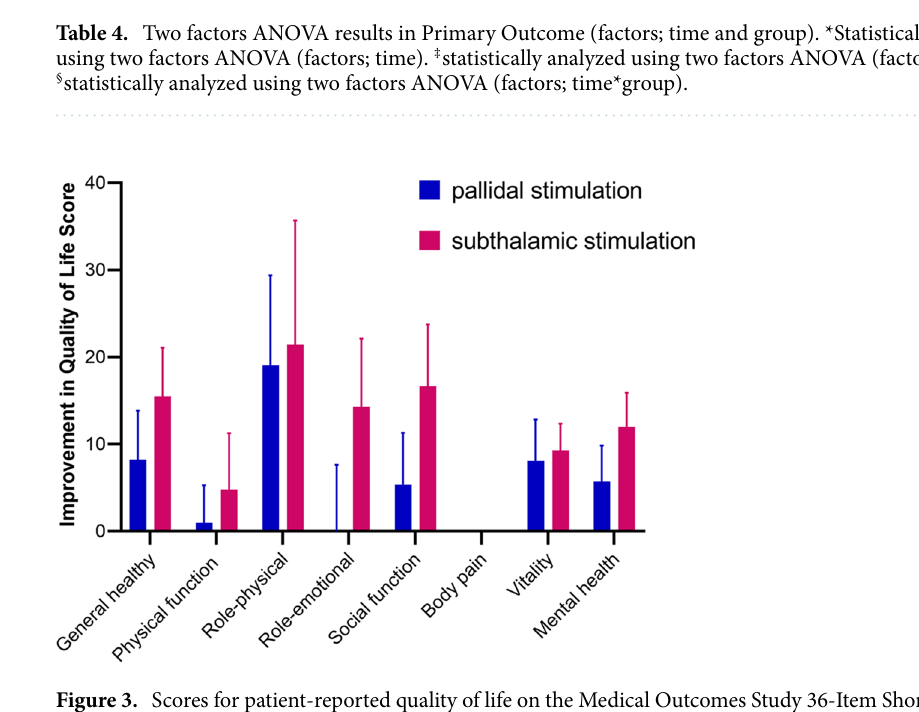
Figure 3. Scores for patient-reported quality of life on the Medical Outcomes Study 36-Item Short-Form General Health Survey (SF-36), with higher scores indicating better daily function and